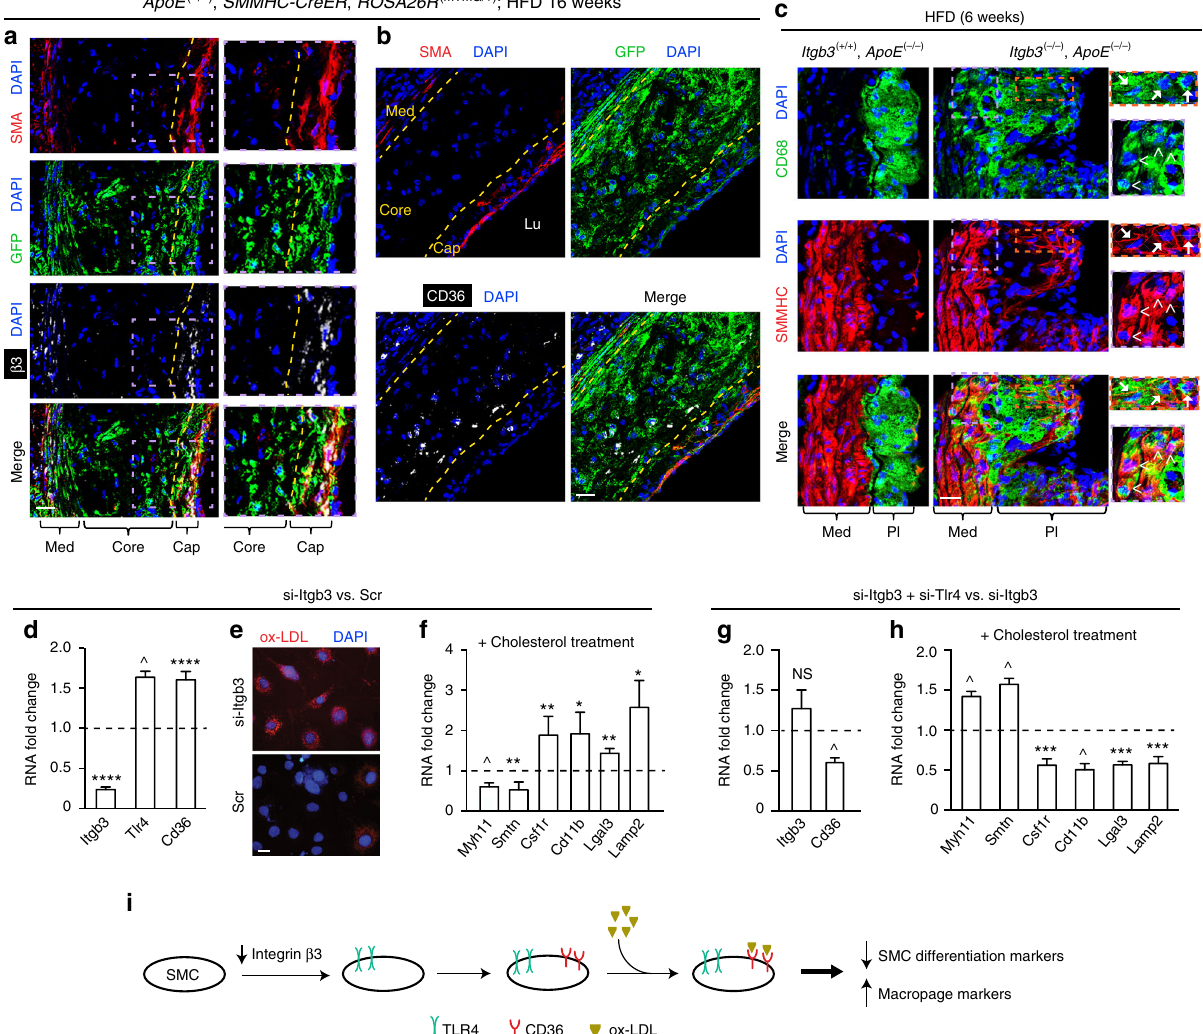
Fig. 5 Integrin β 3 modulates SMC transdifferentiation. a – c Mice were fed a HFD for 6 or 16 weeks as indicated, and then transverse aortic root sections were stained. In a , b sections from ApoE ( − / − ) , SMMHC - CreER T2 , ROSA26R ( mTmG / + ) mice were stained for SMA, GFP (fate marker), nuclei (DAPI), and either integrin β 3 ( a ) or CD36 ( b ). Dashed yellow lines separate cap from core ( a , b ) and core from media ( b ). n = 5. In c sections from ApoE ( − / − ) mice that were also wild type or null for Itgb3 were stained for SMMHC, CD68, and nuclei (DAPI). n = 3. Boxed regions ( a , c ) are shown as close-ups on right; in c CD68 + SMMHC + cells in the media (arrowheads) and plaque (arrows) of the Itgb3 null atherosclerotic aorta are indicated. Med, tunica media; Lu, lumen; Pl, plaque. Scale bars, 25 μ m. d – h Aortic SMCs were isolated from ApoE ( − / − ) mice and then subjected to siRNA-mediated knockdown with si-Itgb3 vs. scrambled (Scr; d – f ) or with si-Itgb3, si-Tlr4 vs. si-Itgb3 ( g , h ). Levels of indicated transcripts from qRT-PCR are relative to Gapdh and normalized to either Scr in d , f or to si-Itgb3 in g , h . For d , g , n = 4 – 5 in duplicate. In e silenced SMCs were cultured with DiI-conjugated ox-LDL for 10 h and stained with DAPI; n = 5. In f , h silenced SMCs were exposed to soluble cholesterol:methyl- β -cyclodextrin complexes for 3 days, and then mRNA levels were assessed; n = 4 – 7 in duplicate. * , ** , *** , ^ , **** vs. control (Scr in d , f and si-Itgb3 in g , h ), p < 0.05, p < 0.01, p < 0.005, p < 0.001, and p < 0.0005, respectively. NS, not signi fi cant. Student ’ s t -test was used, and error bars represent standard deviations. i Schematic of the effect of β 3 reduction via TLR4 and CD36 in